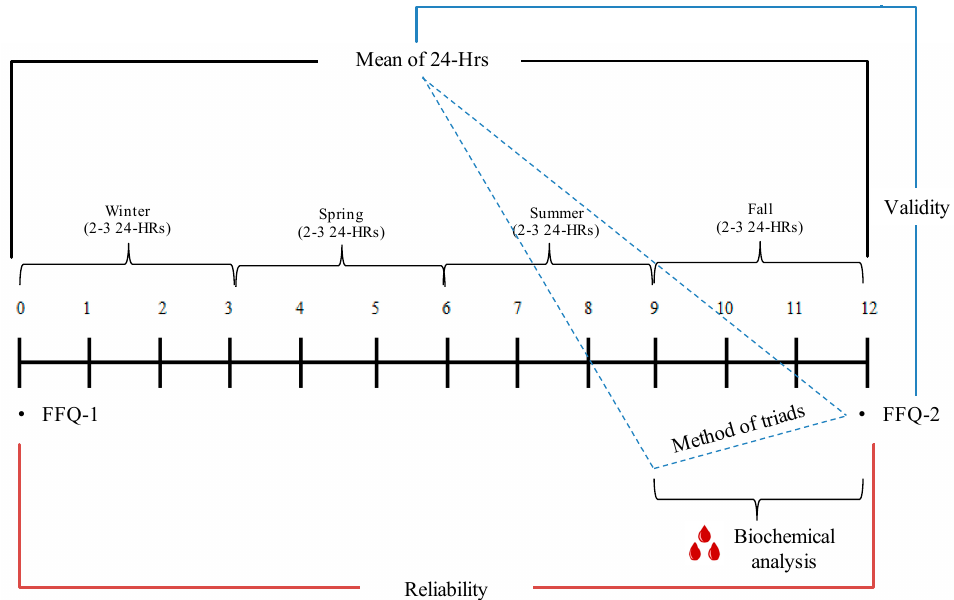
Figure 1. Design of the validation and reliability study of a culture specific food frequency questionnaire (FFQ) among Lebanese adults .